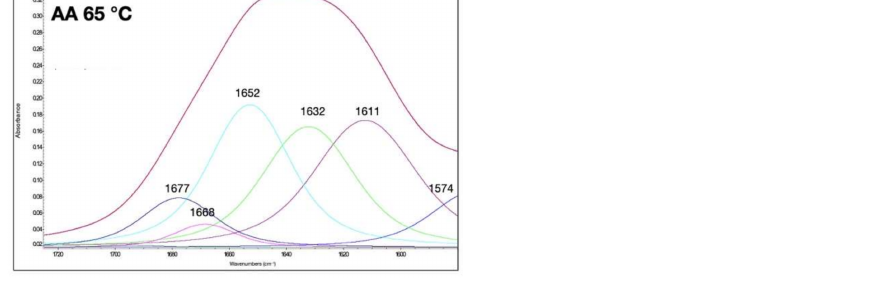
Figure 2. Amide I band of gluten at 25, 45, and 65 ◦ C and with ascorbic acid (AA; 100 ppm) treatment. The secondary structure determination by the curve-fitting procedure is indicated.